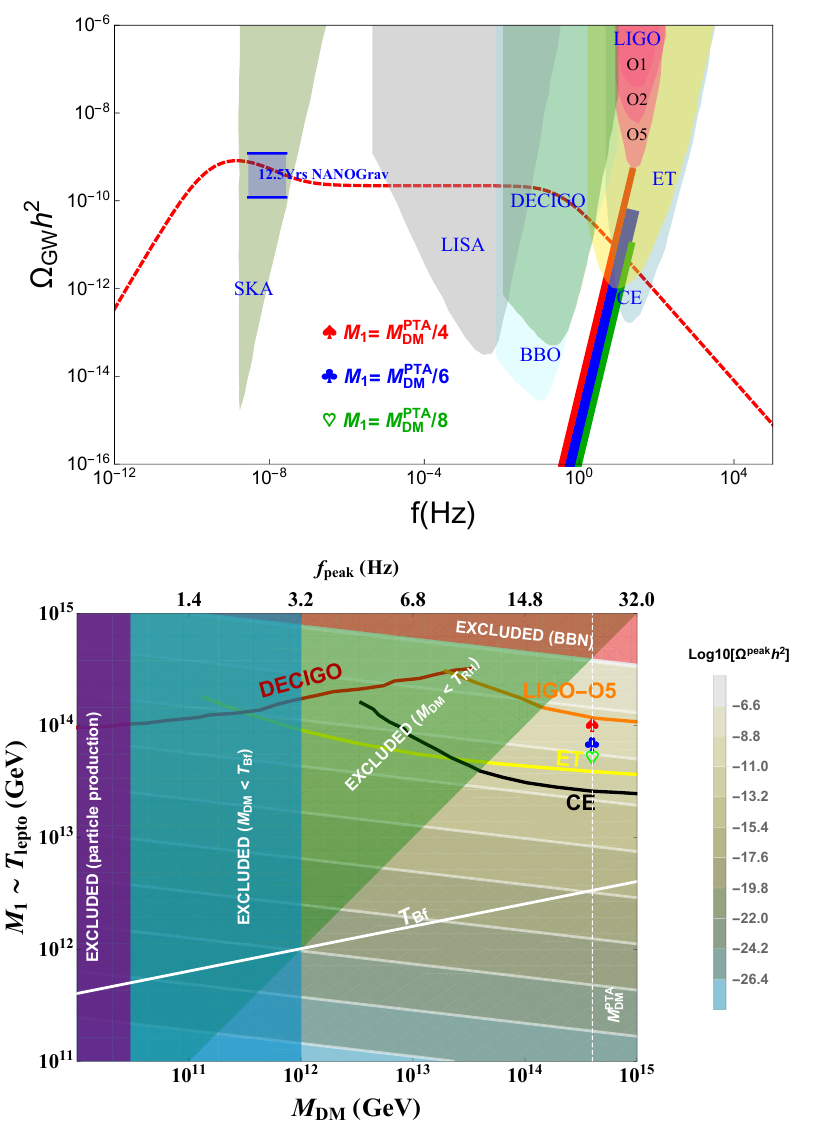
Figure 4 . Top: GW signatures of U (1) B − L -seesaw in presence of ultralight PBHs. The dashed red line shows GWs from cosmic strings for M DM = 4 × 10 14 GeV. The slanted ver- tical bars show GWs from PBH density fluctuation corresponding to M 1 = M DM /x , where x = 4 (red) , 6 (blue) and 8 (green) . The coloured regions represent the nominal sensitivities of several current and planned GW detectors as well as the NANOGrav result. Bottom: contours of Ω peak on the M 1 − M DM plane, containing the benchmark cases shown on the left panel. See the GW text for the explanation of the exclusion